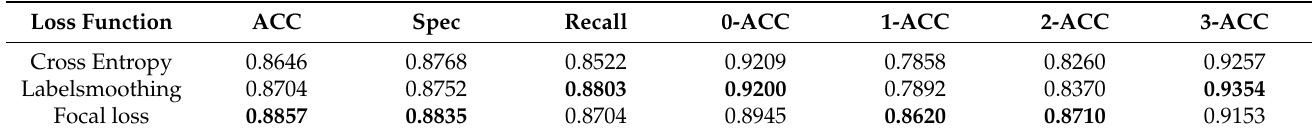
Figure 5. Comparative experimental results of the loss function. Due to the imbalance in classes, focal loss outcompetes other losses during the training process. Table 4. Comparative experimental results of the loss function.